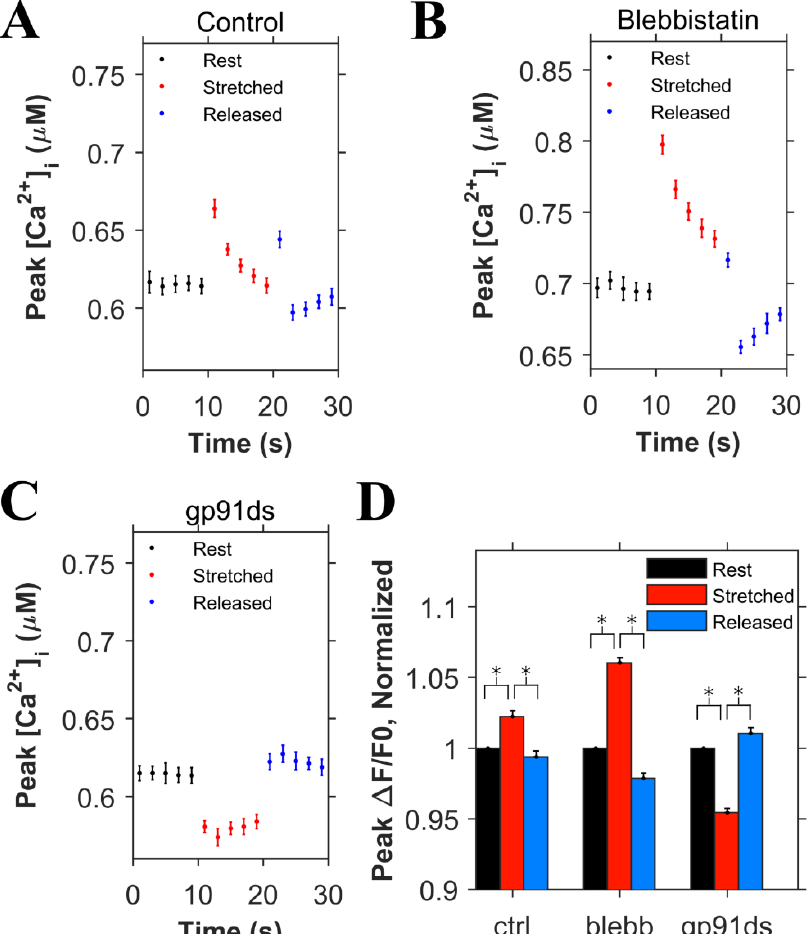
Figure 5. Simulation results (n = 20 simulations) for the peak concentration of Ca 2+ in the myoplasm ([Ca 2+ ] i ) with 0.5 Hz stimulus when the cardiomyocyte is at rest length (black), stretched (red) and released after the stretch (blue). A . Under control condition. B . When blebbistatin which inhibits the actin myosin bridge is used. C . When gp91ds is used which inhibits NOX2 from producing stretch-dependent ROS. D . The peak ([Ca 2+ ] i ) under each subgroup (rest, stretched and released) of each group (control, blebbistatin and gp91ds) is averaged, its corresponding ΔF/F0 is calculated and normalized. * p < 10 − 14 .